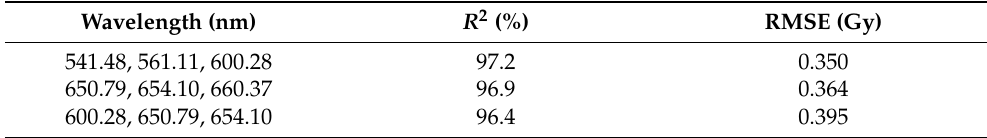
Table 5. Results of multiple linear regression technique using selected wavelengths for the 6-MV photon beam and 6-MeV electron beam source. Wavelength (nm) R 2 (%) RMSE